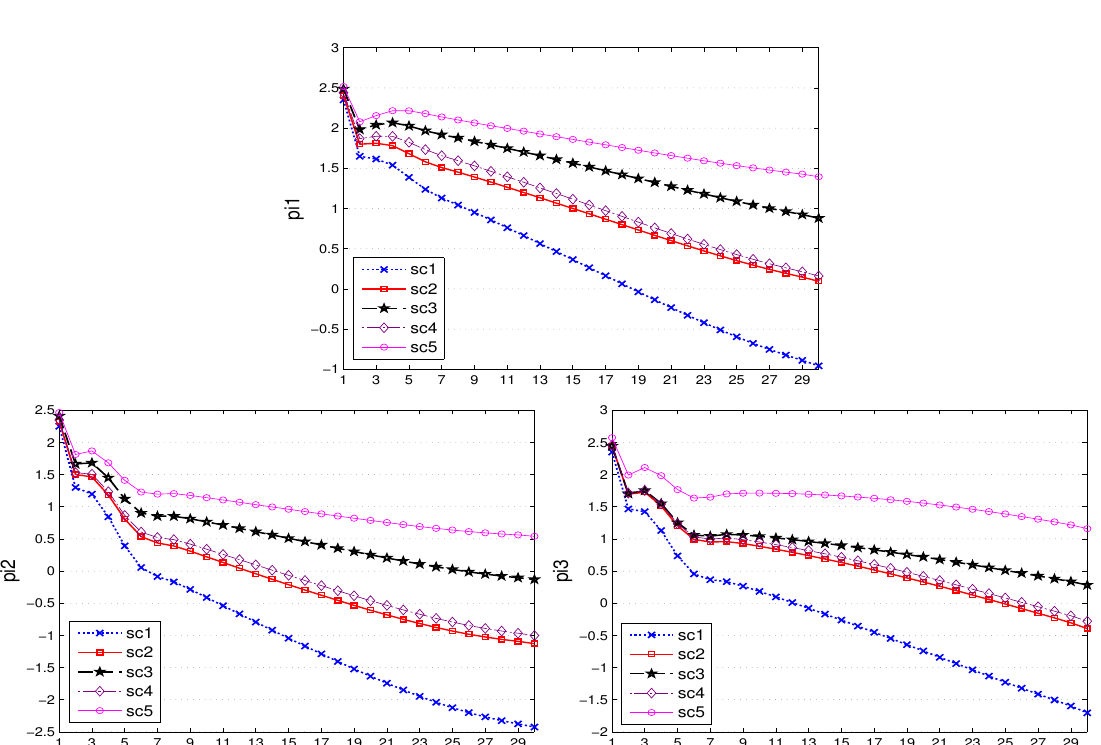
Figure 2. State variable, output ( y it ).